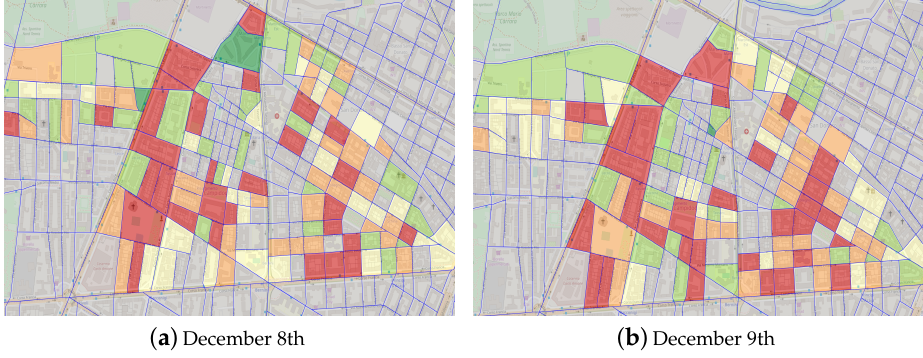
Figure 3. Total consumption of the buildings in the monitored district, grouped by neighborhood.